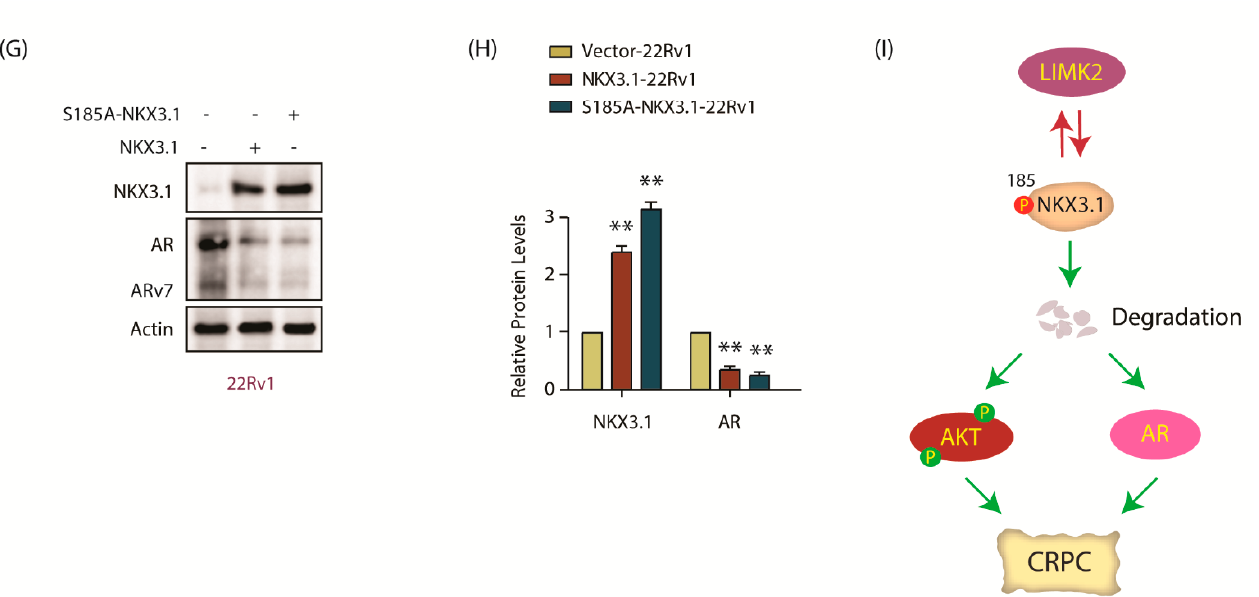
Figure 7. NKX 3.1 inhibits AKT phosphorylation, and depletes AR and ARv7. ( A ) Levels of phospho-AKT in NKX3.1- and S185A-NKX3.1-overexpressing C4-2 cells are much lower than vector-expressing control cells. Control, NKX3.1-C4-2, and S185A-NKX3.1-C4-2 cells were assayed for p-AKT levels along with AKT and actin; ( B ) The histogram shows changes in AKT phosphorylation levels in response to NKX3.1 and S185A-NKX3.1 expression. The data obtained from three independent experiments were normalized against actin and represented as mean ± SEM [** p < 0.01, ns = not significant]; ( C ) The extent of AKT phosphorylation is lowered by ectopic overexpression of wild-type and phospho-resistant NKX3.1 in 22Rv1 cells. p-AKT and AKT levels in vector control, NKX3.1-22Rv1, and S185A-NKX3.1-22Rv1 cells were monitored using Western blot analysis; ( D ) Quantification of AKT phosphorylation levels obtained from three independent experiments as depicted in C. [** p < 0.01, ns = not significant]; ( E ) Both wild-type NKX3.1 and S185A-NKX3.1 deplete AR protein levels in C4-2 cells. The effect of ectopic expression of wild-type and phospho-resistant NKX3.1 on AR protein levels was examined using Western blot; ( F ) The bar graph shows change in AR and NKX3.1 protein levels normalized against actin. The data from three independent experiments were plotted with ** p < 0.01 compared to vector-expressing cells; ( G ) Ectopic expression of NKX3.1 and S185A-NKX3.1 decreases AR and ARv7 protein levels in 22Rv1 cells. Vector-expressing control, wild-type NKX3.1, and phospho-resistant NKX3.1-overexpressing 22Rv1 cells were lysed and probed for AR and ARv7 protein levels using Western blot analysis; ( H ) The bar graph shows changes in AR and ARv7 protein levels in 22Rv1, NKX3.1-22Rv1, and S185A-NKX3.1-22Rv1 cells. The data from three independent experiments were plotted as mean ± SEM, ** p < 0.01 vs. 22Rv1 vector-expressing control cells; ( I ) Schematic model portraying the plausible role of LIMK2-NKX3.1 signaling in CRPC